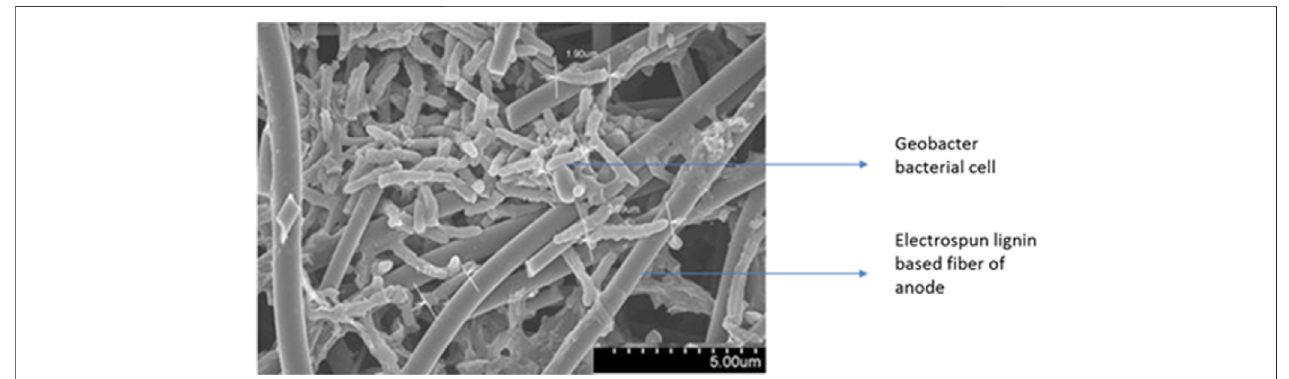
FIGURE 5 | SEM image of Geobacter sulfureducens bio fi lm grown on electrospun lignin anode.